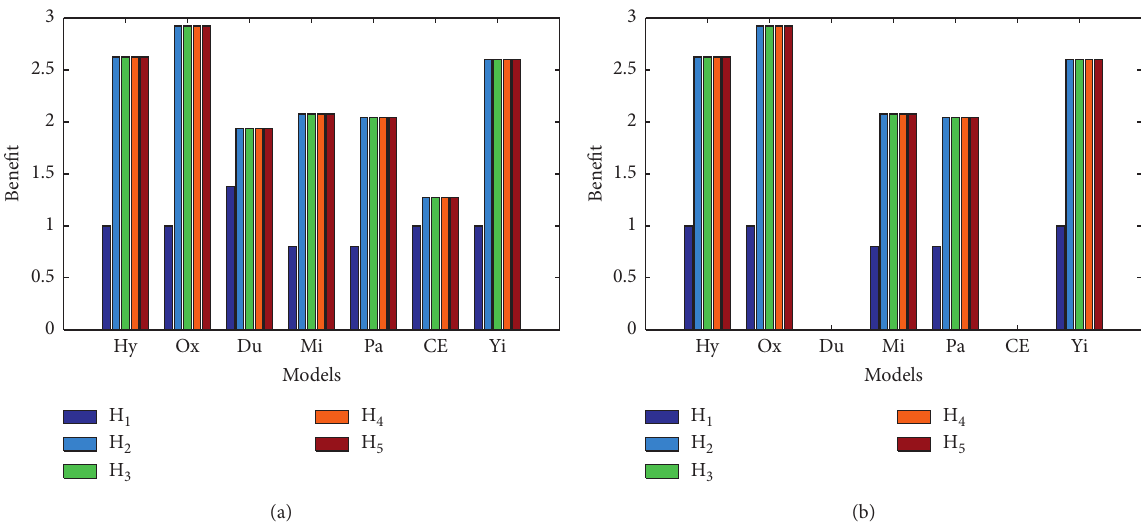
Figure 5: Benefit of each concrete carbonation model according to each hypothesis for structure A (a) and structure B